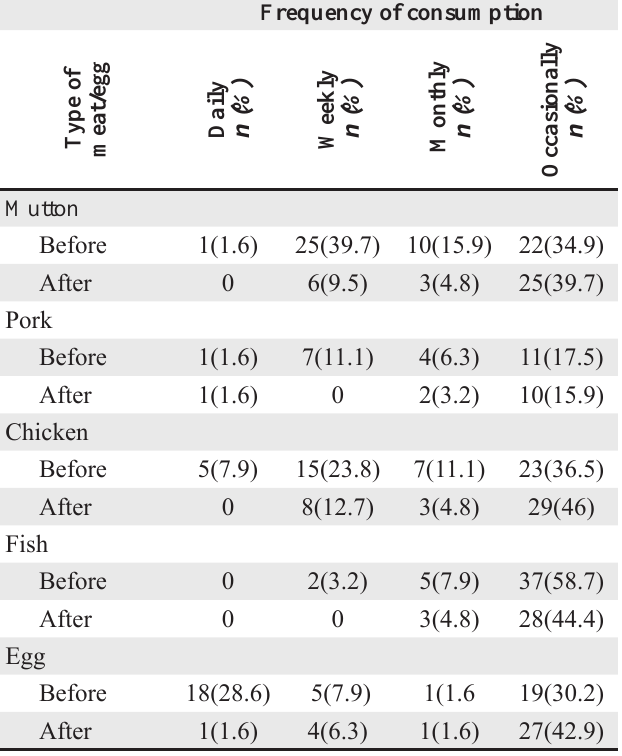
Table 3 : Distribution of respondents according to type of meat consumed and frequency of consumption before and after diagnosis of hypertension